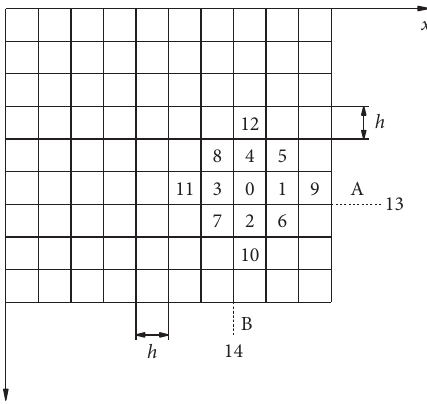
Figure 4: Schematic diagram of the stress difference method.